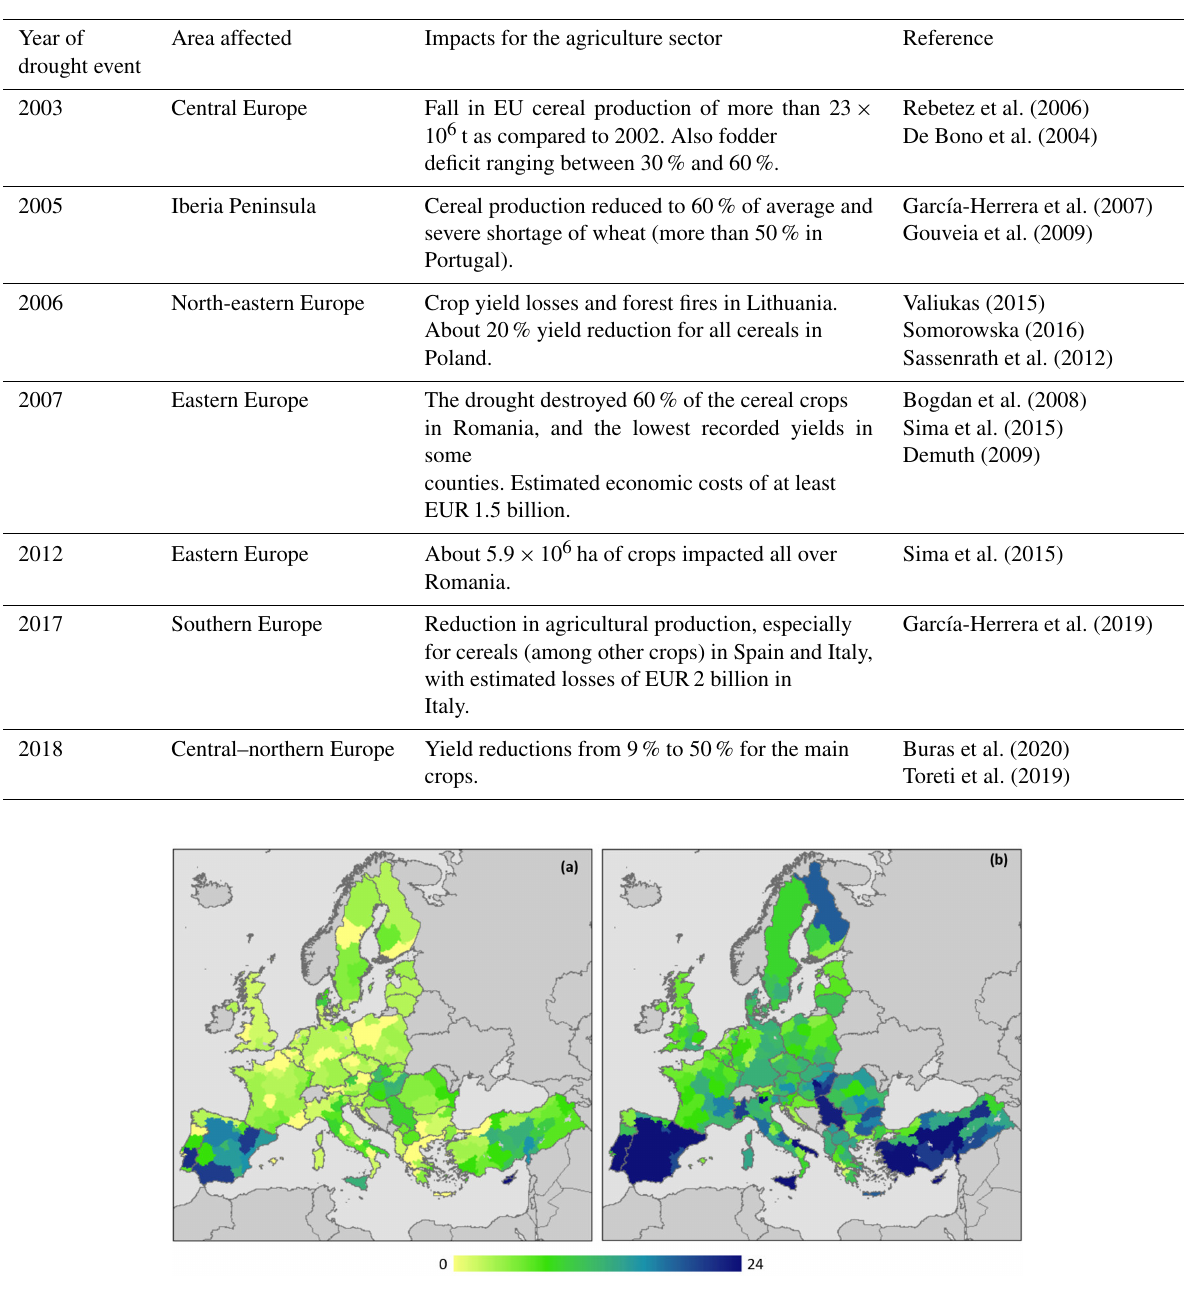
Table 1. Main European drought events between 2001 and 2018 corresponding to the large patterns in negative yield anomalies ( < − 1) observed in the maps reported in Fig. 2. References to the scientific literature of each event are also reported, with a brief description of the documented impacts for the agriculture sector.